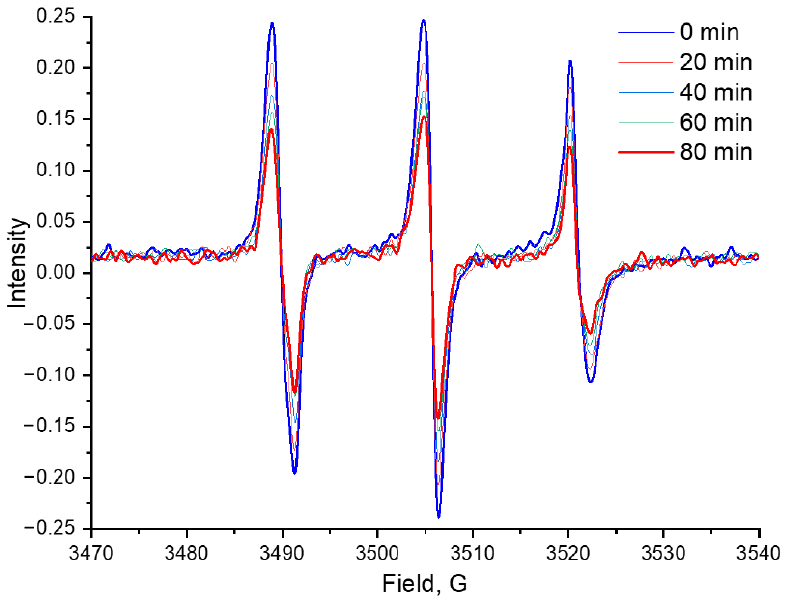
Figure 3 . EPR spectra of Eu(III) complex 10a in DMSO at r.t. over time . Figure 3. EPR spectra of Eu(III) complex 10a in DMSO at r.t. over